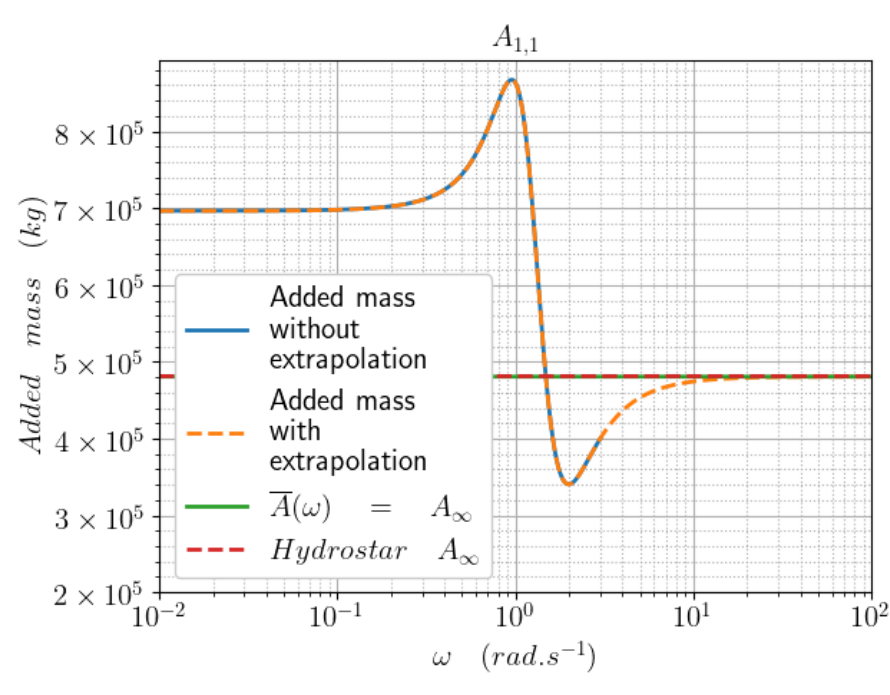
Figure 2. Example of extrapolation for A jk with j = k = 1.